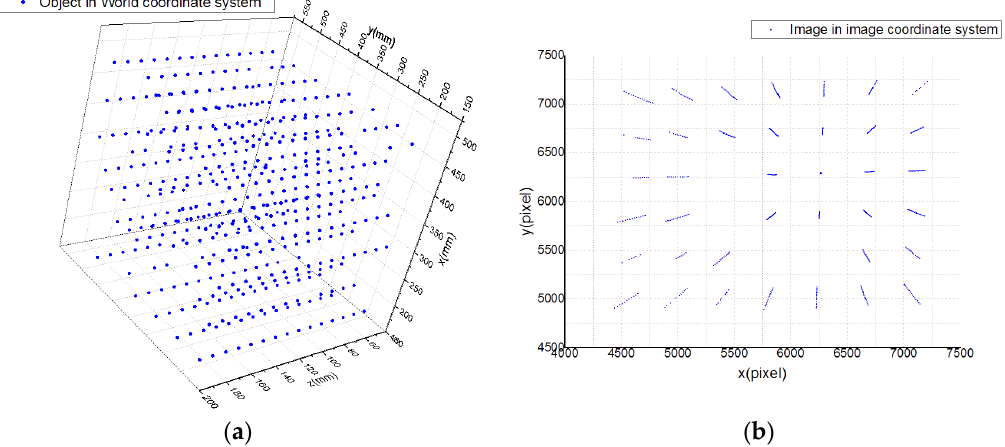
Figure 6. Test data set: ( a ) world coordinates and ( b ) image coordinates.